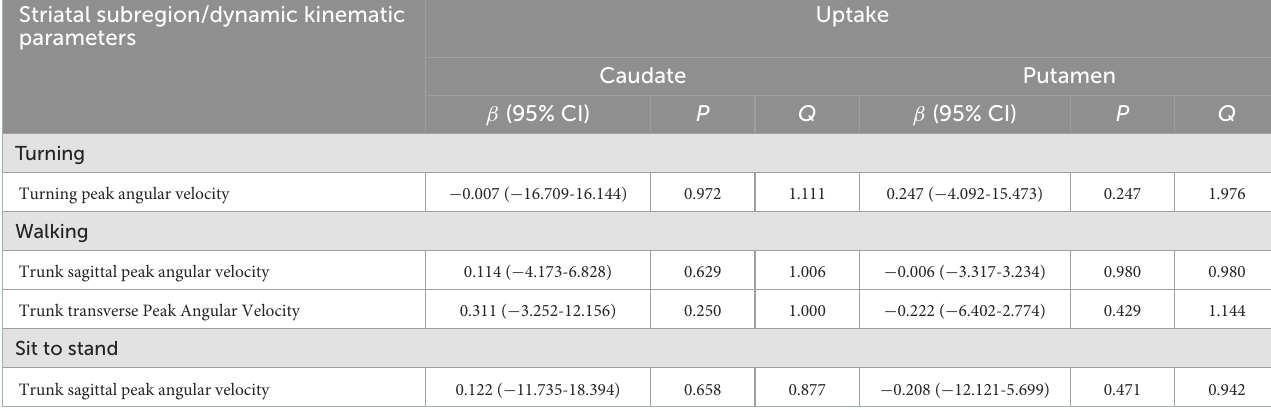
TABLE 4 Multivariate linear regression analyses for the DAT uptake in each striatal subregion for parameters related to disease progression. Striatal subregion/dynamic kinematic